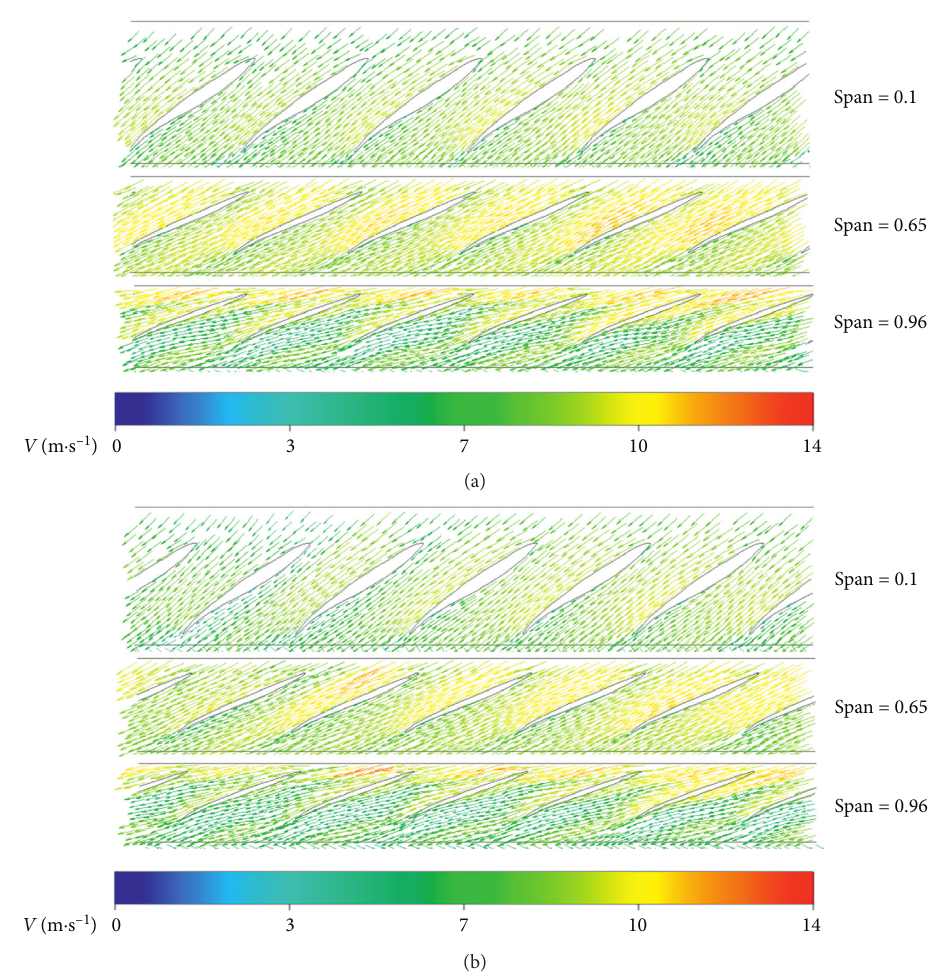
Figure 19: Velocity vector on each span of original scheme and selected scheme under 1.0 Q ′ condition: (a) original scheme; (b) selected